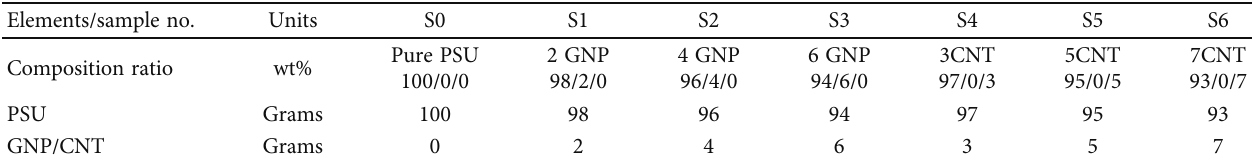
Figure 1: Flow processing diagram for PSU nanocomposite fabrication. Table 3: Compositions of PSU